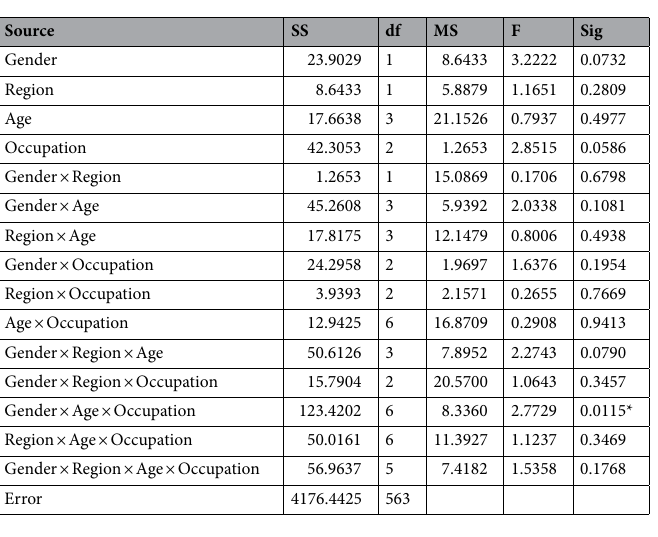
Table 14. Four-way analysis of variance of strengthening one’s immune system with gender, place and occupation. * p < .05.